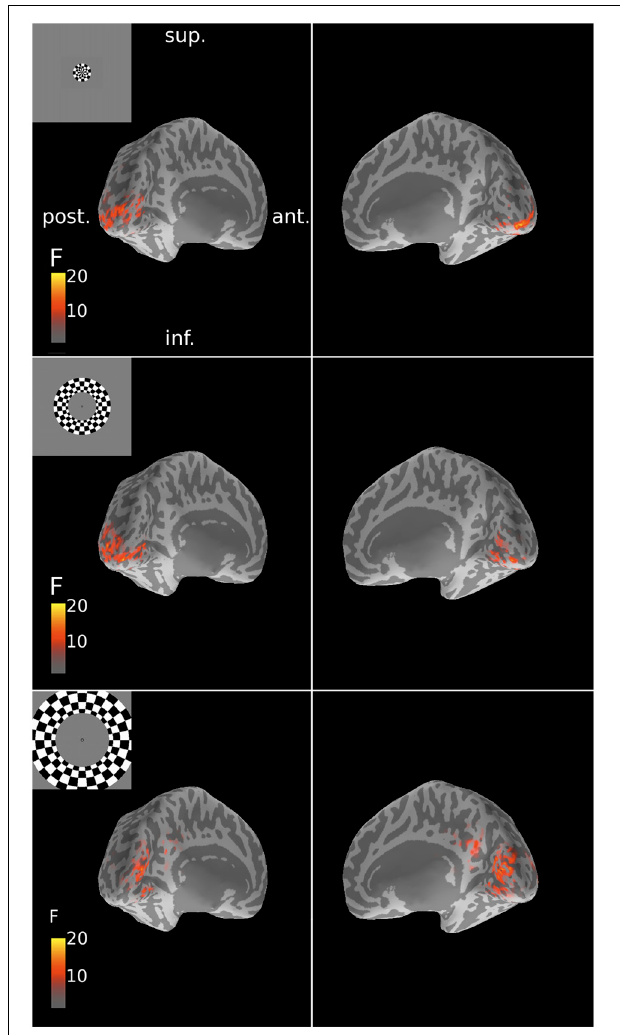
FIGURE 5 | Spatial patterns of MNE source reconstructions of responses to ring stimuli for Subject 6. These reconstructions followed the expected retinotopic posterior-anterior progression with increasing stimulus eccentricity. F-statistic results are presented for left and right inflated cortical surfaces (see Figure 1 ). Insets show the corresponding stimulus locations. Sup., superior; post., posterior; ant., anterior; inf.,